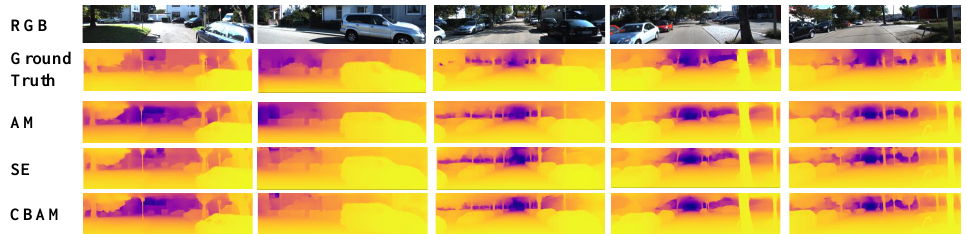
Figure 5. A visualization of the results from our background depth prediction model using the different attention mechanisms: AM, SE, and CBAM. Table 2. The evaluation of our foreground depth prediction model using the different attention mechanisms.